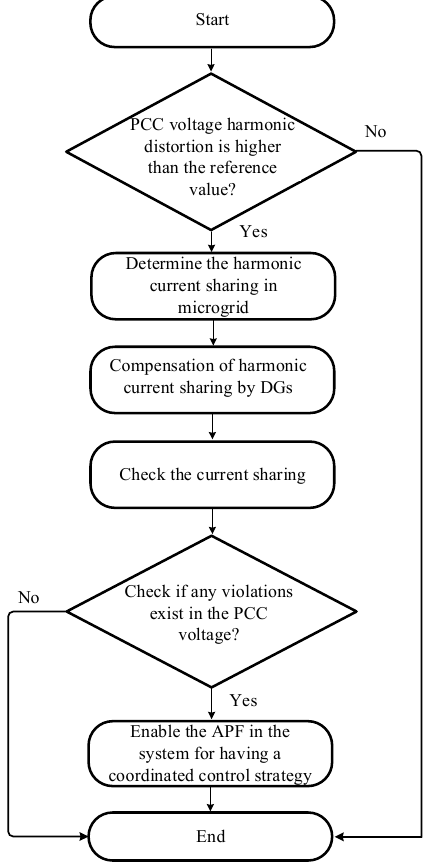
Figure 5. Flowchart of the proposed hierarchical control of DGs and APF.